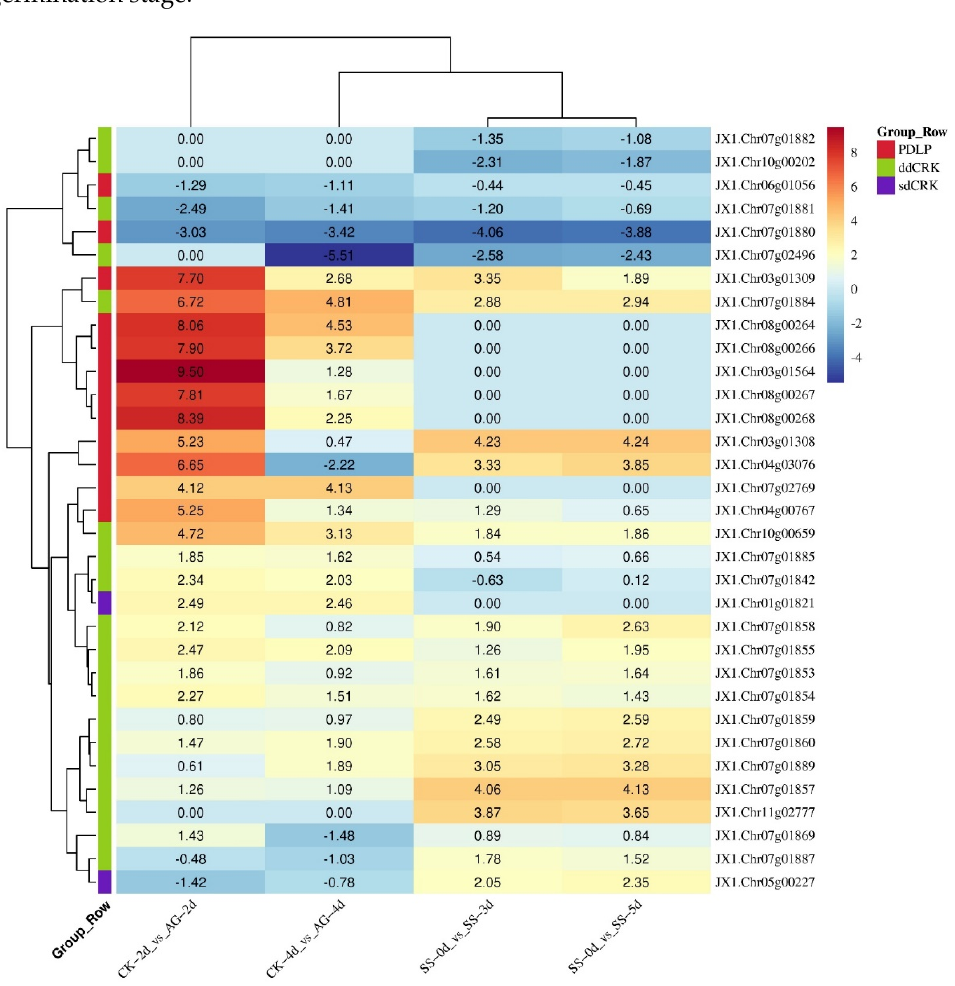
Figure 3. The collinearity analysis of the DXWR and gramineaes plants. Arabic numerals indicate chromosome numbers. The red line highlights the collinearity gene pairs containing the DUF26 do- main-containing genes among different species.